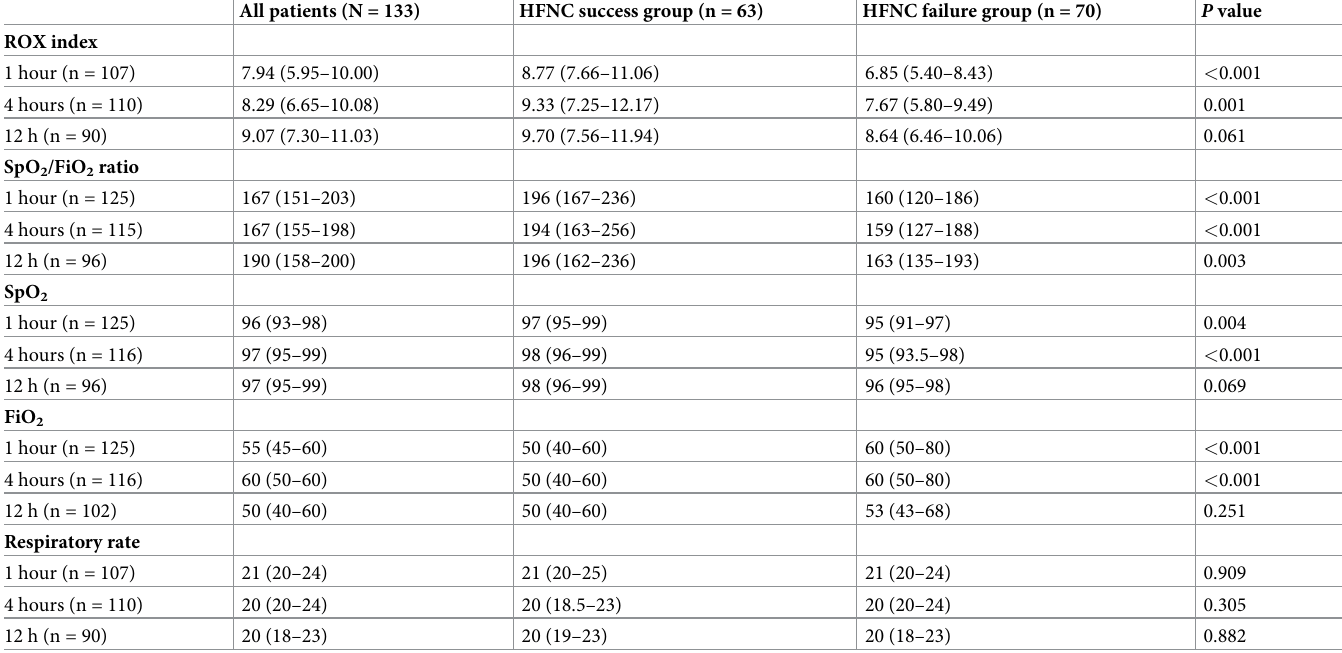
Table 3. Changes in respiratory variables of patients during HFNC (N = 133).